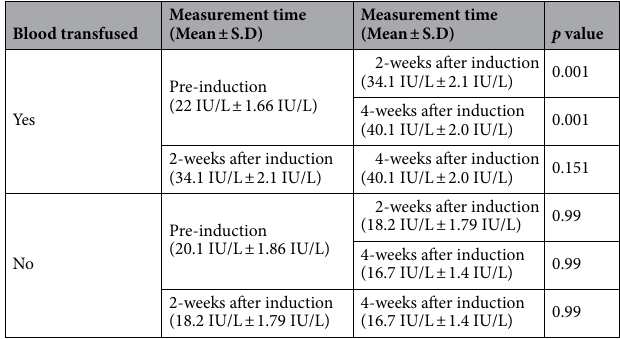
Table 5. Compares the mean alanine aminotransferase before and after